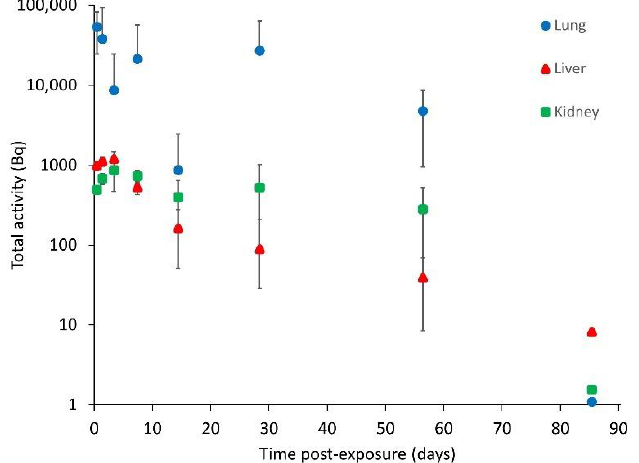
Figure 3. Tritium in lung (blue circle), liver (red triangle) and kidney (green square) (mean ± SD) (note that values without error bars at 85 days are at limit of detection and are included for indicative purposes only).